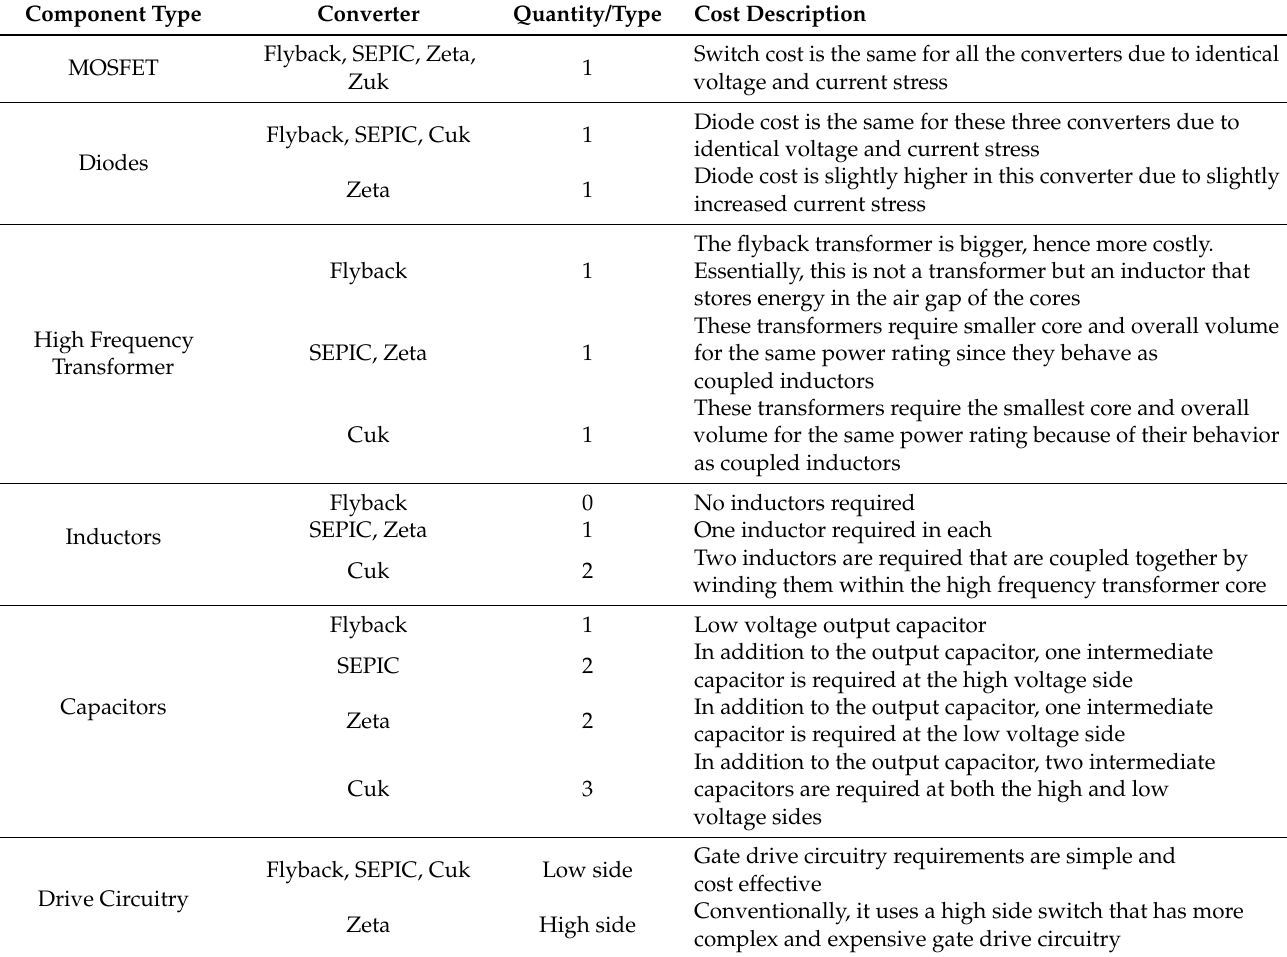
Table 7. Indicative cost comparison table of the isolated buck–boost